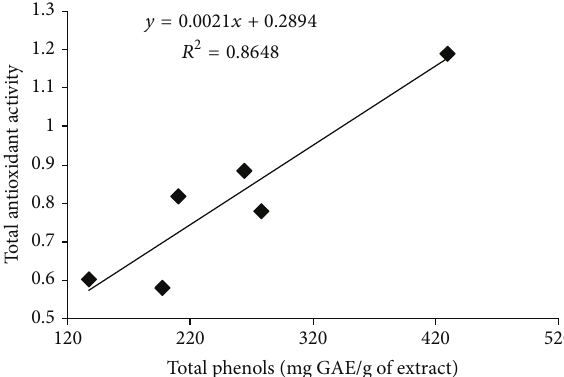
Figure 10: Correlation between total phenols and DPPH scavenging activity of seed extracts of Loranthus pulverulentus . y = 0.0025x + 0.1489